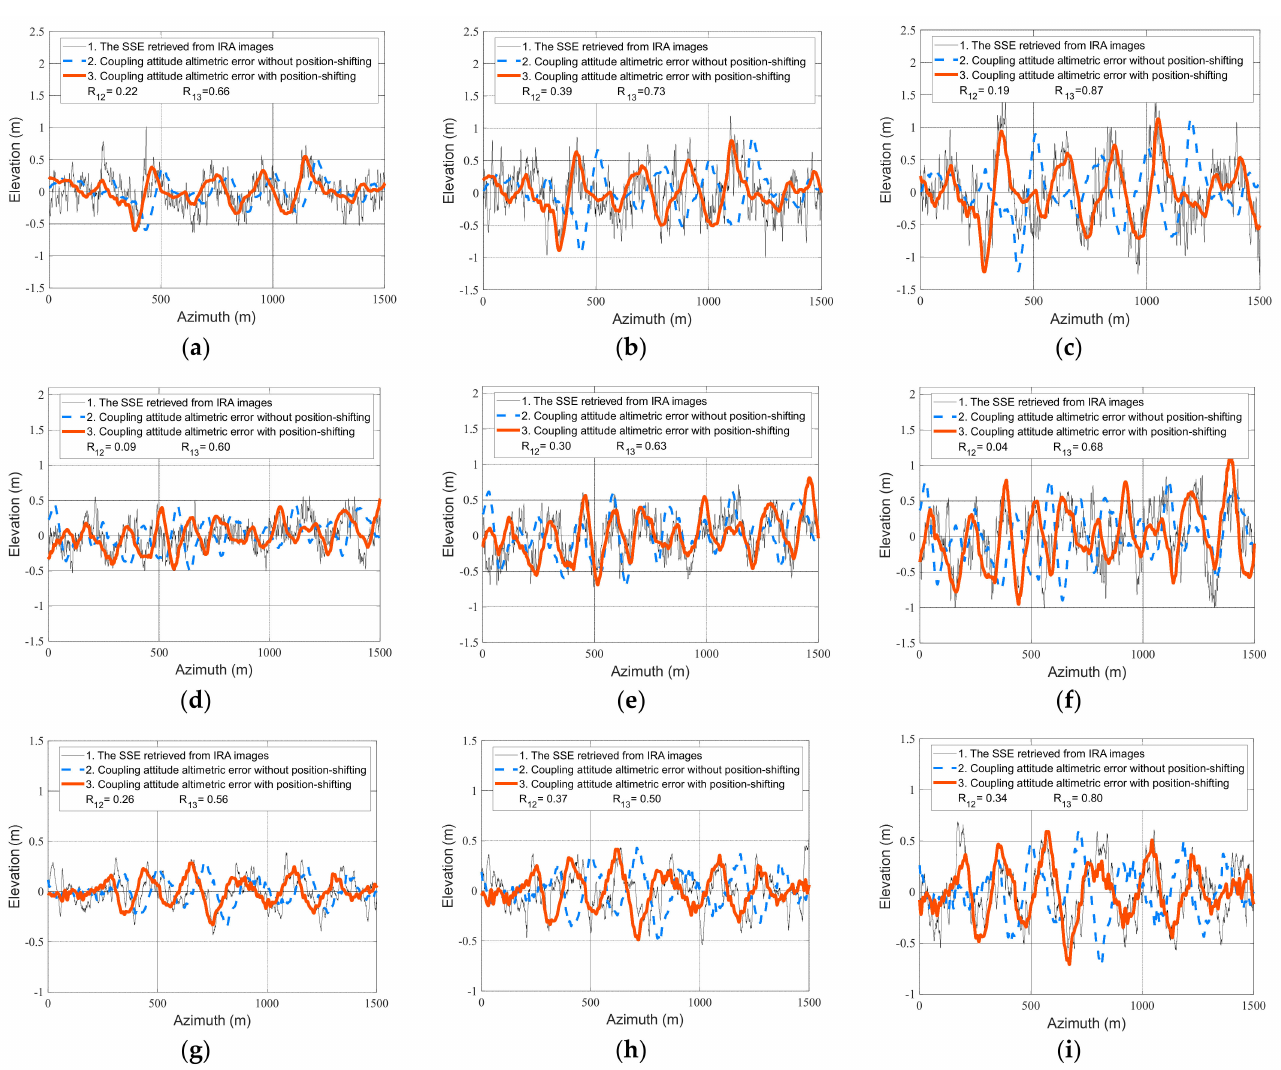
Figure 11. Profiles of the coupling attitude altimetric errors and the SSE retrieved from IRA images. R 12 is the correlation coefficient of the SSE retrieved from IRA images (the thin black solid curves) and coupling attitude altimetric errors without position-shifting (the blue dashed curves), and R 13 is the correlation coefficients of the SSE retrieved from IRA images and coupling attitude altimetric errors with position-shifting (the thick red solid curves). ( a – c ) are the profiles retrieved from RZ14 at the nadir range, middle range, and far range, respectively. ( d – f ) are the profiles retrieved from RZ16 at the nadir range, middle range, and far range, respectively. ( g – i ) are the profiles retrieved from RZ24 at the nadir range, middle range, and far range,